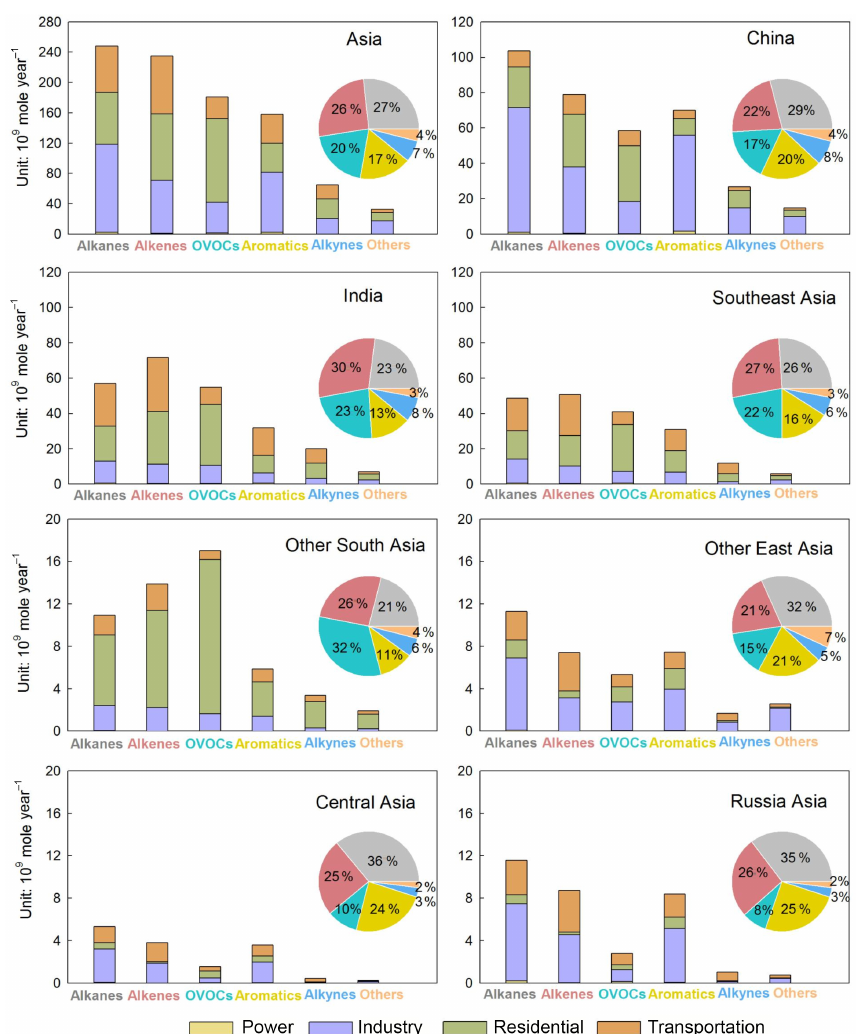
Figure 9. Speciated NMVOC emissions for the year 2010 by chemical group and by Asian regions. Alkanes: ethane, propane, butanes, pentanes, hexanes, higher alkanes and their isomers. Alkenes: ethane, propene, isoprene, terpenes, higher alkenes and their isomers. Alkynes: ethyne and other alkynes. Aromatics: benzene, toluene, xylene, trimethylbenzene, other aromatics and their isomers. OVOCs: aldehydes (formaldehyde, acetaldehyde, and higher aldehydes), ketones (acetone and higher ketones), alcohols (methanol, ethanol, and higher alcohols), ethers, and acids. “Others”: halogenated hydrocarbons, unidentified species,